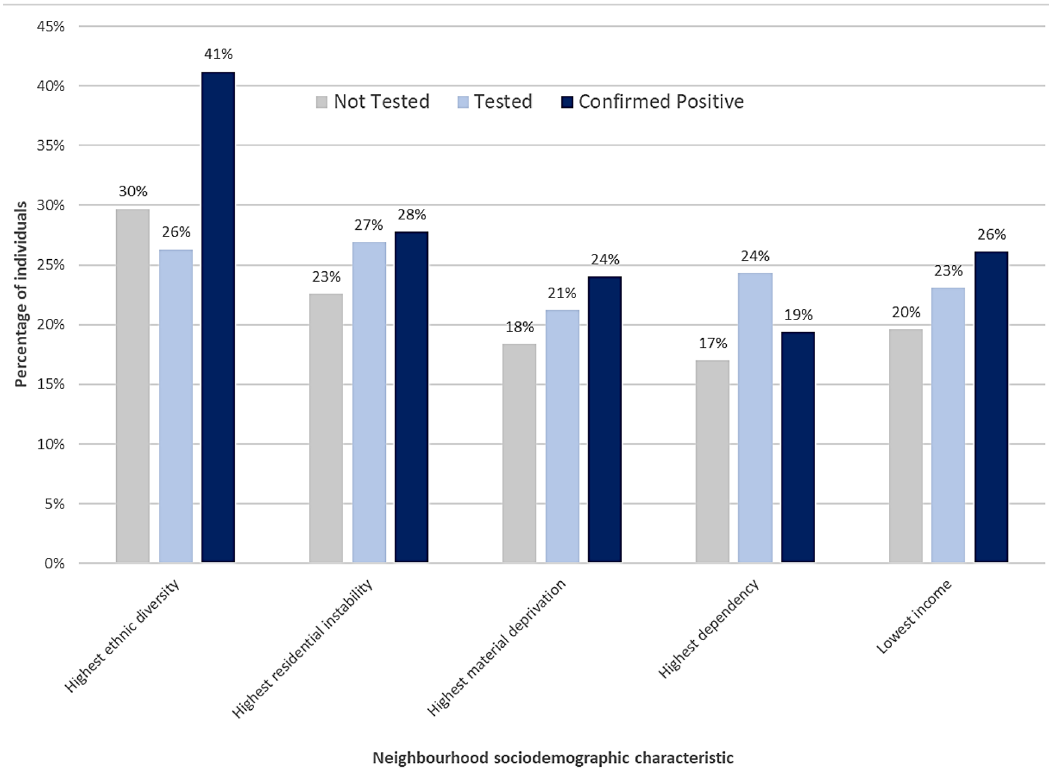
∗ Percentages represent the proportion of all people in each ‘Not Tested’, ‘Tested’ or ‘Confirmed Positive’ group that reside in the most marginalized group for the neighbourhood characteristic of interest. Compared to individuals not tested for SARS-CoV-2, a higher proportion of those tested reside in marginalized neighbourhoods (e.g., greater residential instability, material deprivation and dependency, lower income). Also, individuals confirmed positive for SARS-CoV-2 were more likely to live in neighbourhoods with higher proportions of immigrants and visible minorities. Marginalization was measured using the dimensions of the Ontario Marginalization Index. † From Chung et al. ‘ COVID-19 Laboratory Testing in Ontario: Patterns of Testing and Characteristics of Individuals Tested, as